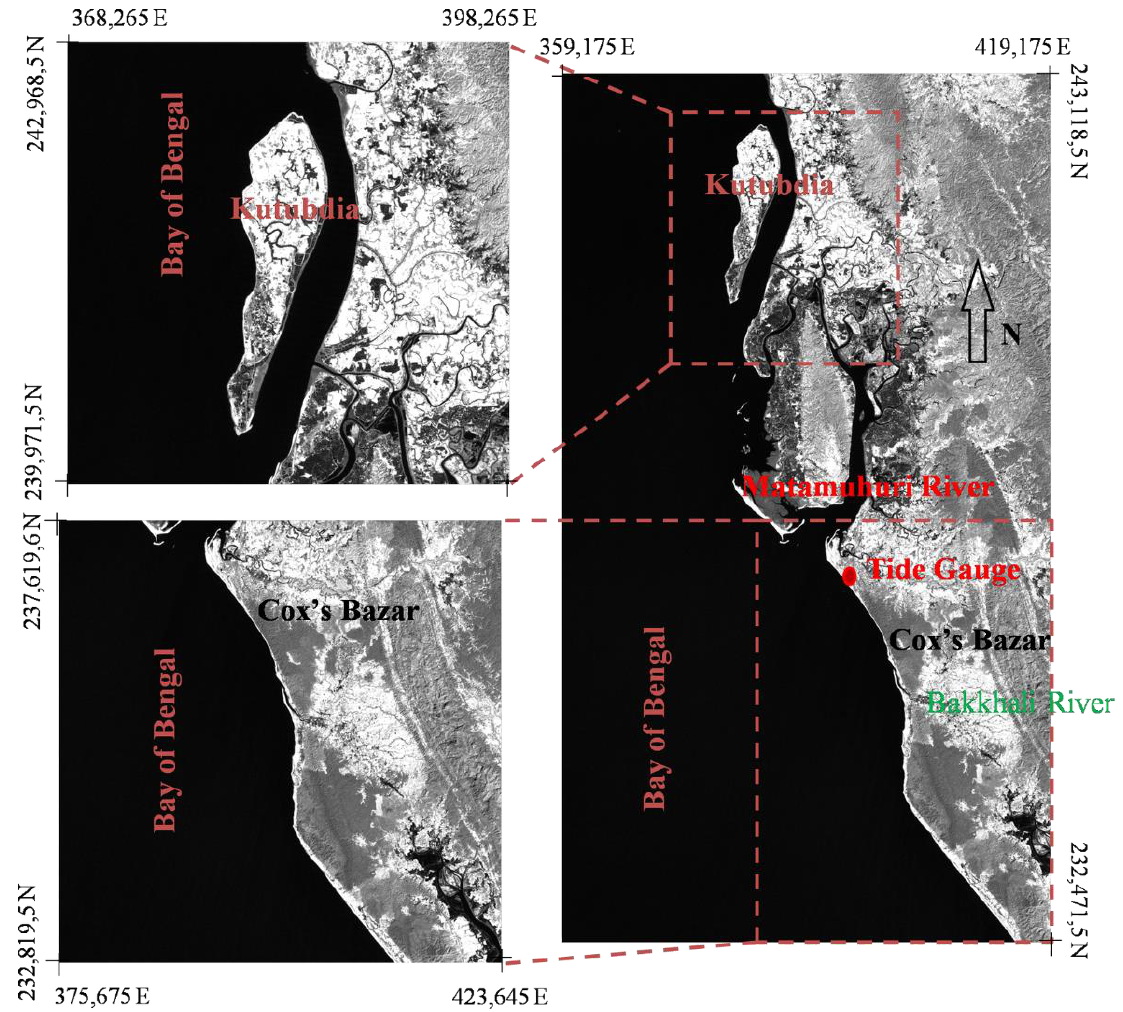
Figure 2. Close view of study area of Cox’s Bazar ( black rectangular box in Figure 1) and nearby Island Kutubdia. The dark portion is the water body, and the bright portion is the land surface (Base Image: LANDSAT 4, Band 5).